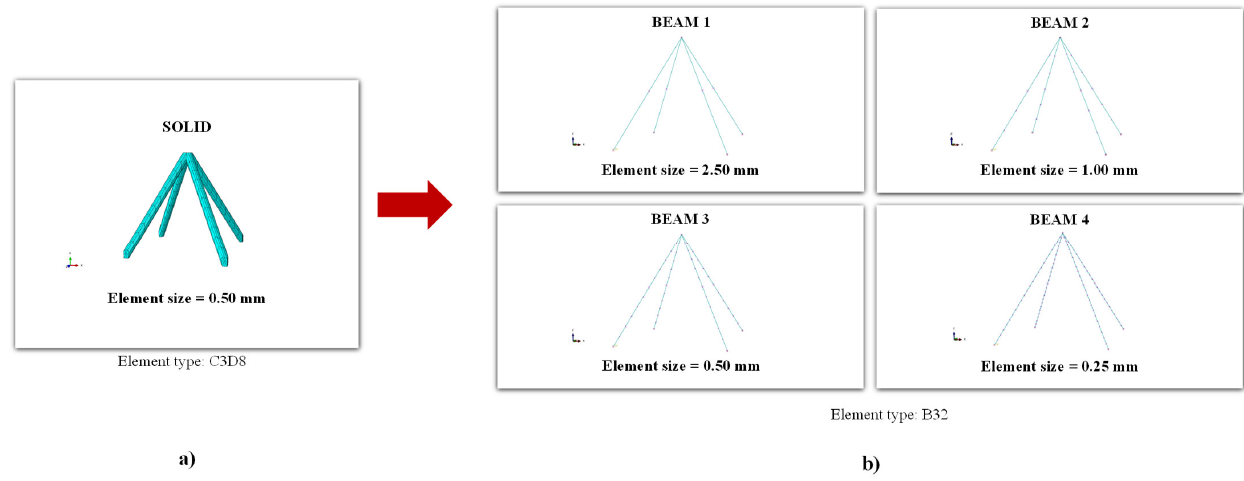
Figure 9. Unit cell discretization: ( a ) formulation with solid C3D8 elements; ( b ) formulation with beam elements.